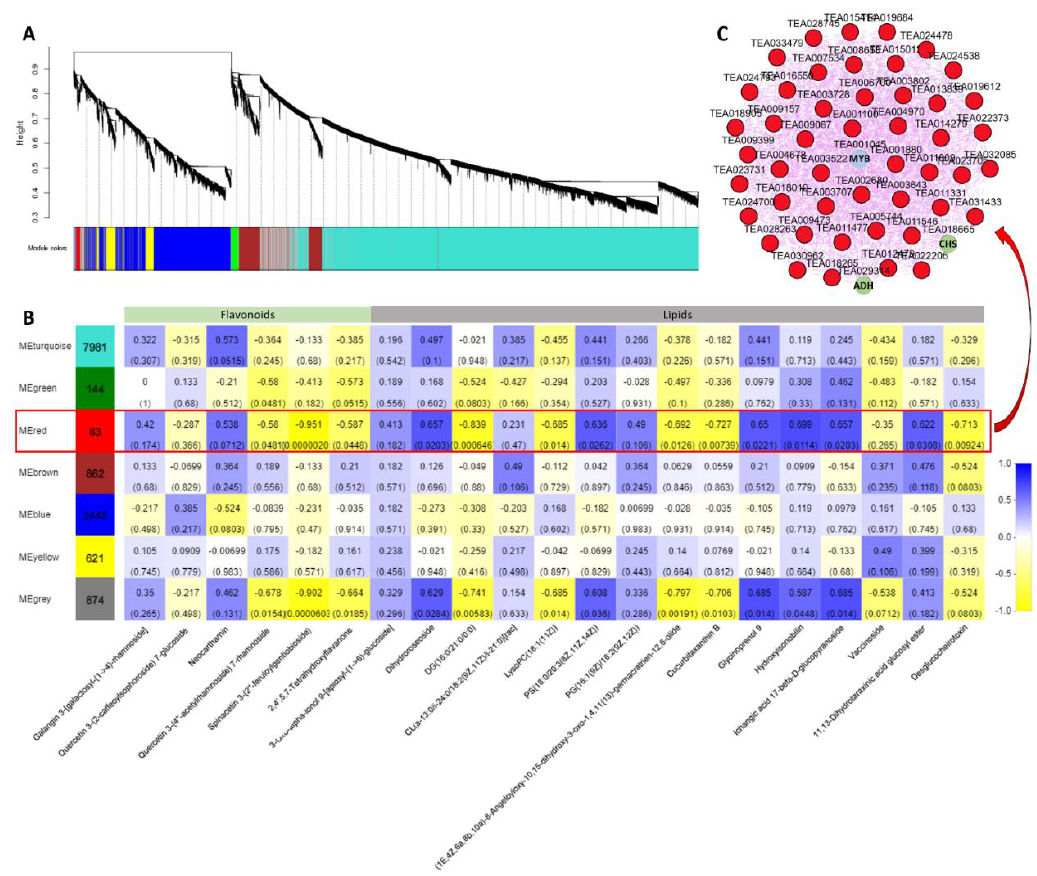
Figure 10. Coexpression network analysis. ( A ) Hierarchical cluster tree showing seven modules obtained by weighted gene co-expression network analysis (WGCNA). The gray modules represent genes that are not divided into specific modules. Each branch in the tree points to a gene. ( B ) Matrix of module-metabolite associations. The data of gene expression profiles under different blue light intensities and the change patterns of flavonoids and lipids in SCMs were combined to perform WGCNA analysis. The number of genes per module is shown in the left box. Correlation coefficients and p -values between modules and metabolites are shown at the row-column intersection. ( C ) Coexpression subnetwork analysis of red modules related to flavonoids and lipid accumulation. The top 50 nodes of the red module were selected to construct the network. The hub gene is shown in blue, and genes involved in flavonoid and lipid metabolism are shown in green.